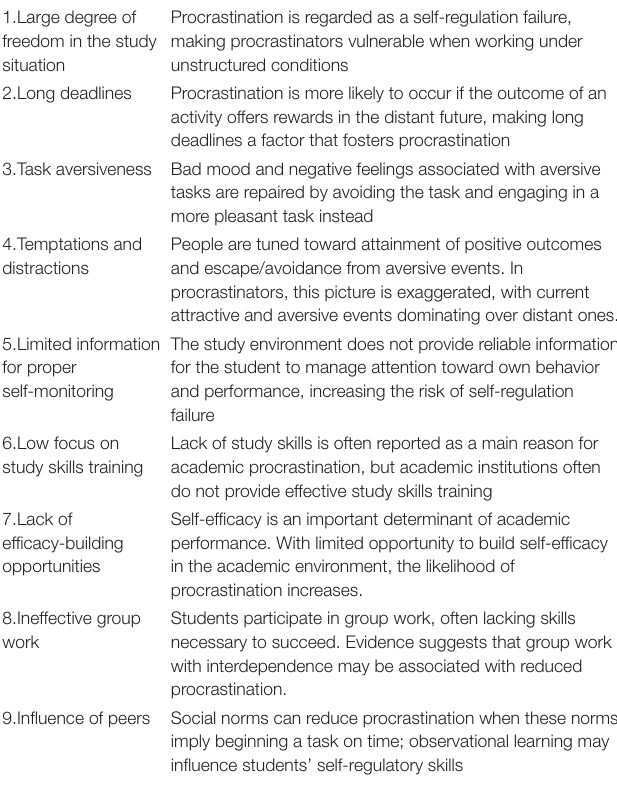
TABLE 1 | Factors reliably associated with procrastination, and their relation to the study